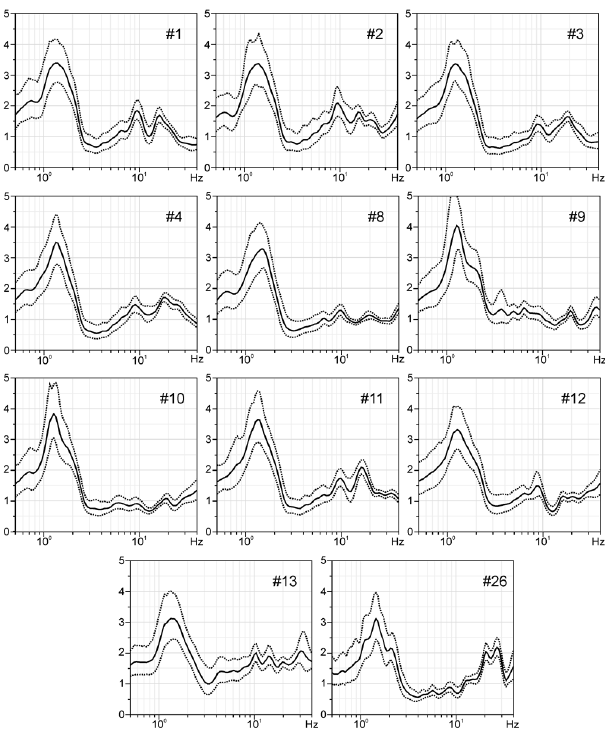
Fig. 6. HVSR results at recording sites located along the fractured zone in the cliff area.